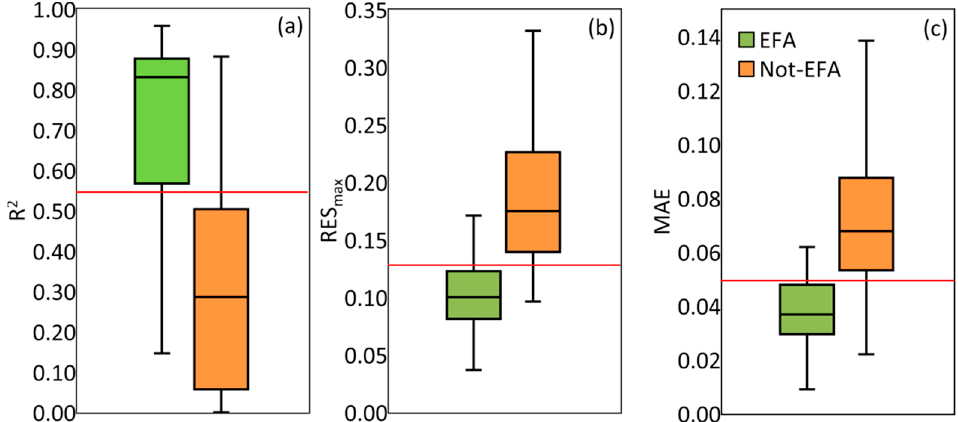
Figure 5. Boxplots of the R 2 , RES max and MAE distributions for EFA and non-EFA: Black lines define (bottom-up) the 5th, 25th, 50th, 75th, and 95th percentiles; ( a ) R 2 distribution; ( b ) MAX res distribution; ( c ) MAE distribution. Red lines indicate the threshold values defined by Otsu’s method and used in this work for each marker.